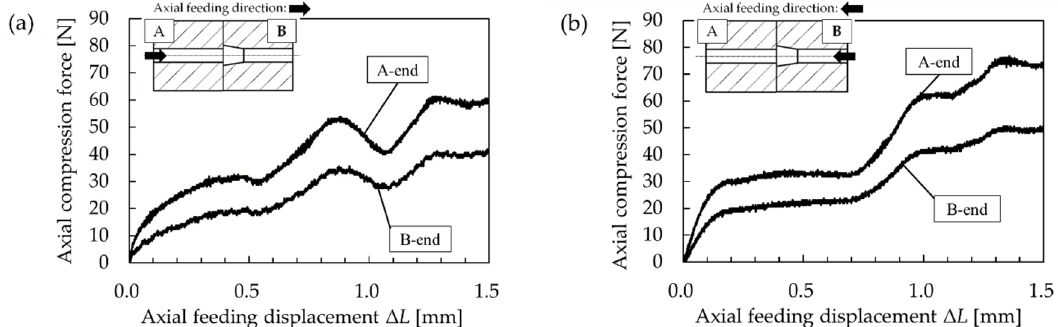
Figure 15. E ff ect of the axial feeding direction on the axial compressive force during the process: ( a ) no wrinkle; ( b ) wrinkle.